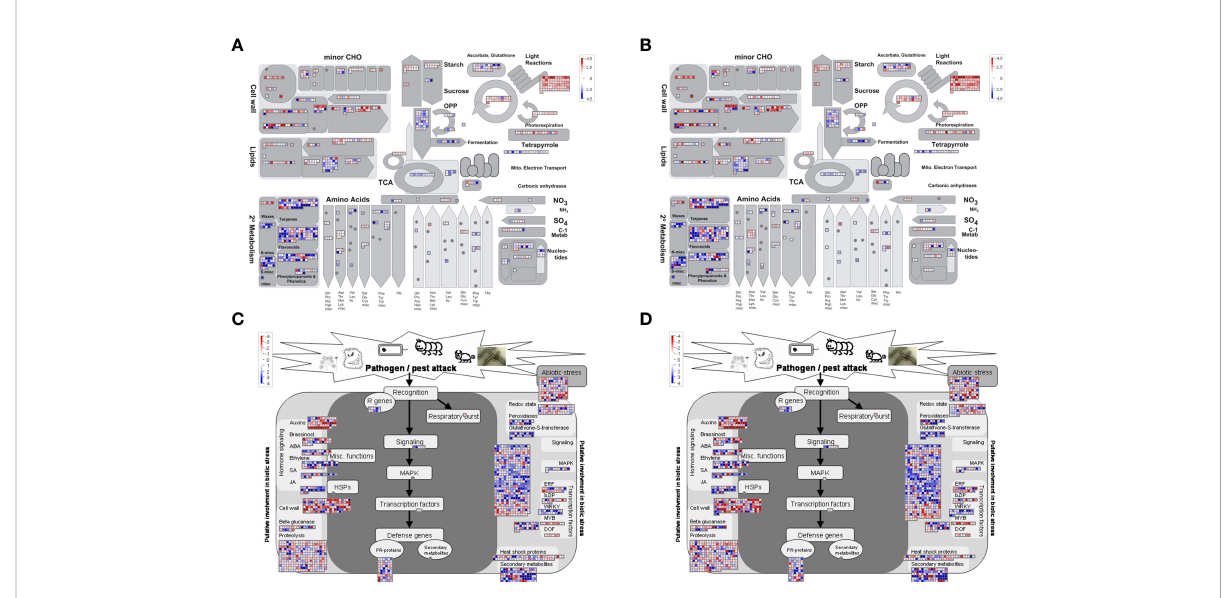
FIGURE 5 Visualization of enriched metabolic pathways in Fragaria vesca leaves after b -aminobutyric acid (BABA) treatment and Botrytis cinerea infection. Differentially expressed genes (DEGs) were displayed onto metabolic pathways using the MAPMAN software ( A, B : central metabolism pathways; C, D : biotic stress pathways). (A, C) DEGs in Botrytis cinerea -infected vs . mock-infected plants [No-BABA and infected (NBI) vs . No-BABA and non-infected (NBNI)]. (B, D) DEGs in BABA-treated and Botrytis cinerea -infected plants vs . mock-infected plants (BABA and infected (BI) vs . NBNI). Blue cells: upregulation compared to NBNI; red cells: downregulation compared to